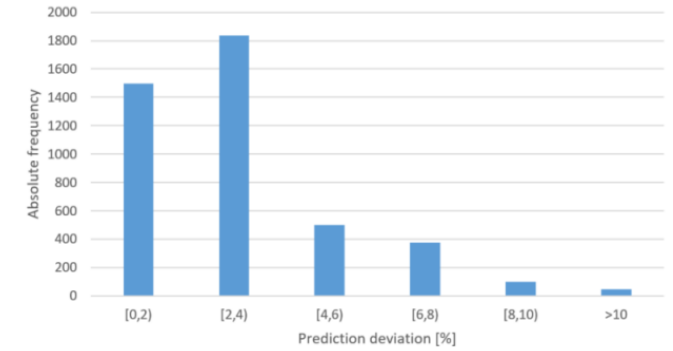
Figure 7. Histogram of the prediction error of the Young’s modulus for all